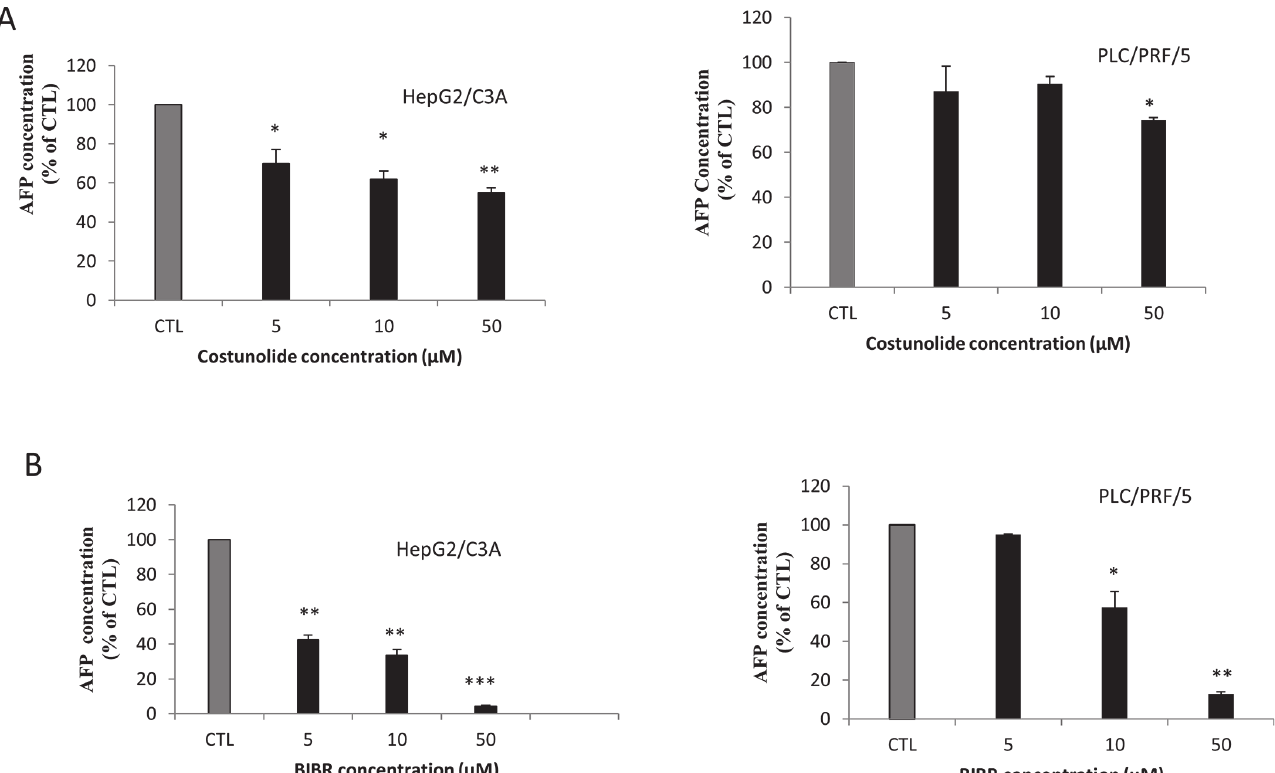
Fig 1. Effect of costunolide and BIBR1532 on AFP secretion by HepG2/C3A and PLC/PRF/5 cell lines. The cells were seeded in 75-cm 2 flasks in DMEM (1g/L). At 80% confluence, the cells were treated with costunolide (5, 10 or 50 μ M) or BIBR1532 (5, 10 or 50 μ M) for 48 h. The supernatant was then collected for ELISA. (A) Costunolide (5 – 50 μ M) significantly decreased AFP production in a dose-dependent manner in the supernatants of HepG2/C3A cells after 48 h of treatment, whereas 50 μ M costunolide decreased the AFP levels in the supernatant of PLC/PRF/5 cells. (B) BIBR1532 (5, 10 or 50 μ M) significantly decreased AFP production in a dose-dependent manner in the supernatants of HepG2/C3A cells after 48 h of treatment. The same pattern was observed in the supernatants of PLC/PRF/5 cells after treatment with BIBR1532 at 10 or 50 μ M. Each value represents the mean of at least three different assays. Each value had its own control which was set as 100%. Each datapoint represents the mean ± SD from all of the experiments. * P < 0.01 versus untreated cells. ** P < 0.005 versus untreated